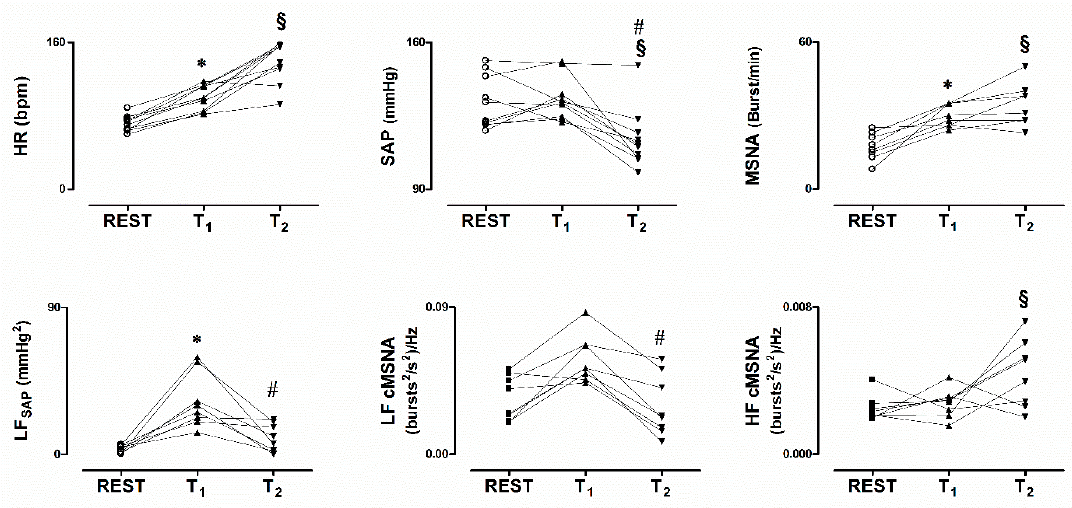
Figure 2. Individual values of heat rate (HR), systolic arterial pressure (SAP) and MSNA while supine (REST), during asymptomatic 80° head-up tilt (T 1 ) and during pre-syncope (T 2 ), in the upper panels. In the lower panels values of the low frequency spontaneous oscillation of SAP (LF SAP ) and MSNA variability (LF cMSNA ) are depicted. Notice hypotension in the presence of persistently elevated HR and MSNA during T 2 . In addition, T 2 was characterized by a decrease of the power of the low frequency components of both SAP and cMSNA variability. * p < 0.05 REST vs T 1. # p < 0.05 T 1 vs T 2. § p < 0.05 REST vs T 2.